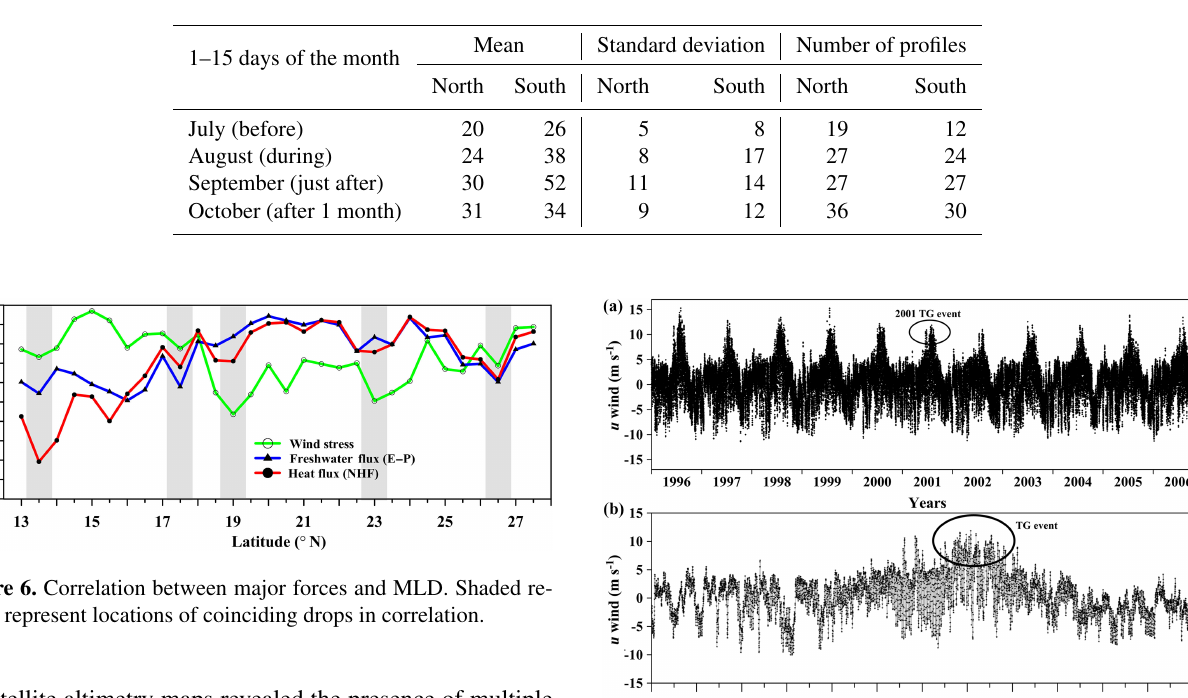
Table 1. The mean MLD in the north and south of the Tokar jet axis from July to October.